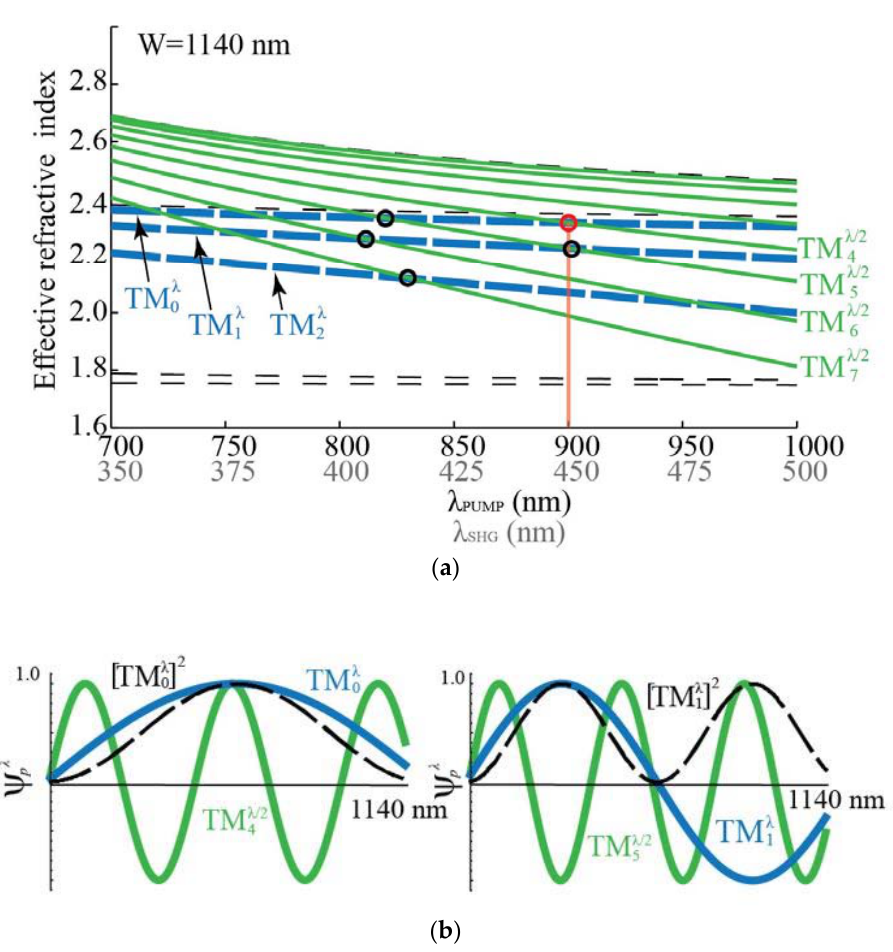
Figure 5. ( a ) Dispersions of the effective refractive indices for the pump (dashed blue lines) and SHG (green lines) waveguide modes in a GaN waveguide with a thickness of 1140 nm. Dashed black lines represent the dispersions of the extraordinary refractive indices of bulk GaN, given in Equation (4) [20] and sapphire [26]. The red circle indicates the modal-dispersion phase matching (MDPM) interaction, which is responsible for the measured SHG signal. ( b ) Overlapping of the electric field distributions, ψ λ p , for two possible waveguide interactions responsible for the measured SHG signal. The waveguide modes at the pump wave are presented with blue lines, modes at the SHG wavelength with green lines, while squares of pump modes (cid:3427)ψ (cid:3043)(cid:3090) (cid:3431) are presented with black dotted lines.